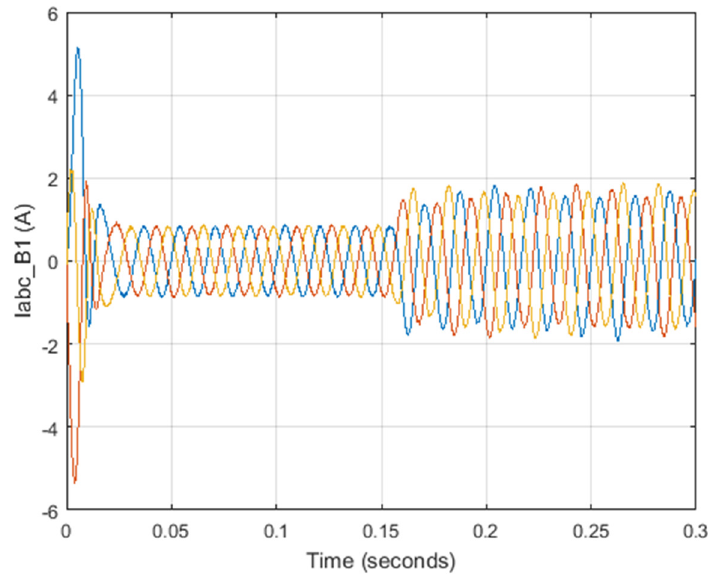
Figure 8. Common point (common base) grid and microgrid current.